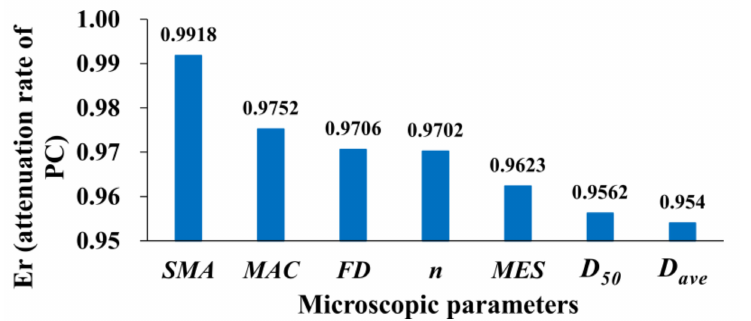
Figure 17. Grey relation entropy between PC attenuation rate and other